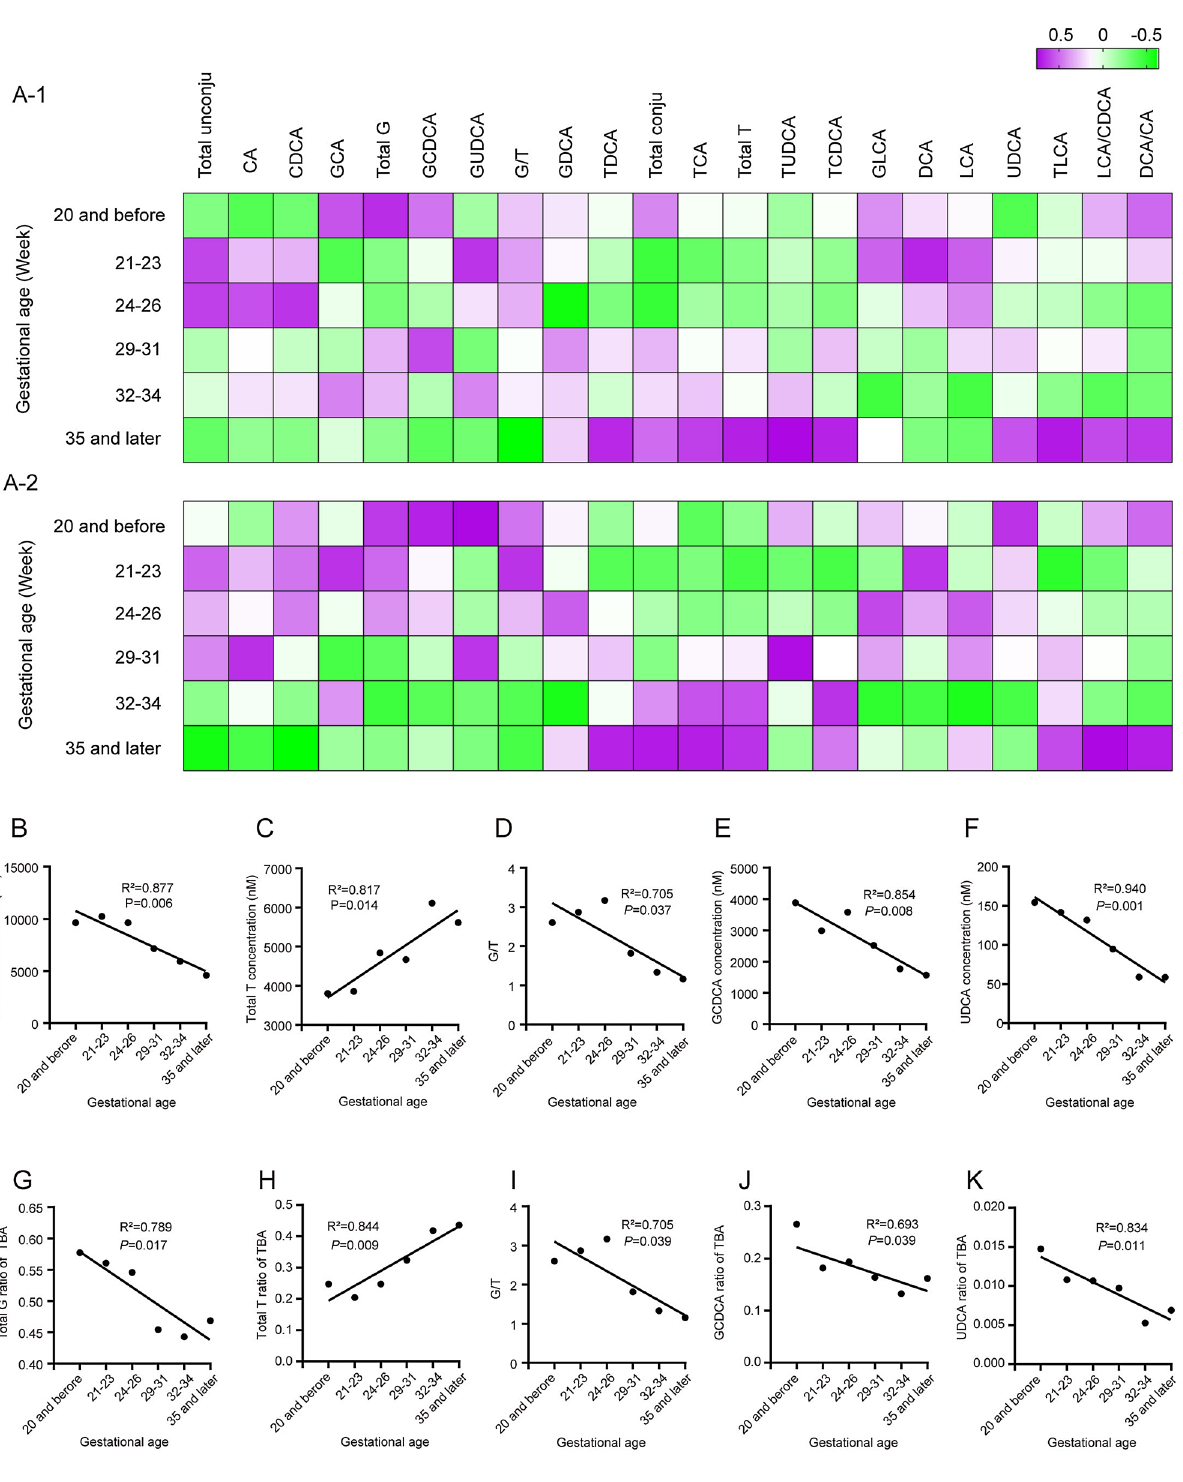
Figure 3. Heatmap showing the BA metabolism profiles that changed with pregnancy advance in normal ( A-1 ) and ICP ( A-2 ). Total unconju: total unconjugated BAs; Total conju: total conjugated BAs; Total G: total glycine conjugated BAs; Total T: total taurine conjugated BAs; G/T: Total G/Total T. Linear changes in concentrations and percentages of total G ( B , G ), total T ( C , H ), G/T ( D , I ), GCDCA ( E , J ), and UDCA ( F , K ) at different diagnostic time points in ICP